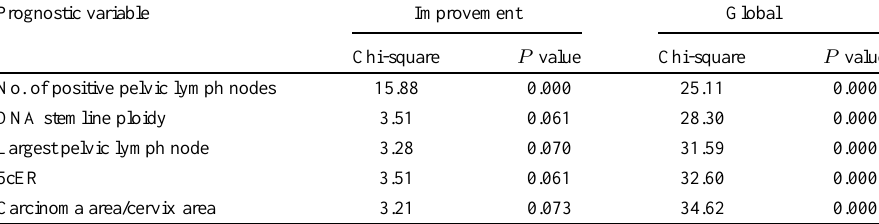
Postsurgery synopsis of prognostic factors in multivariate analysis (Cox proportional hazards regression model) Prognostic